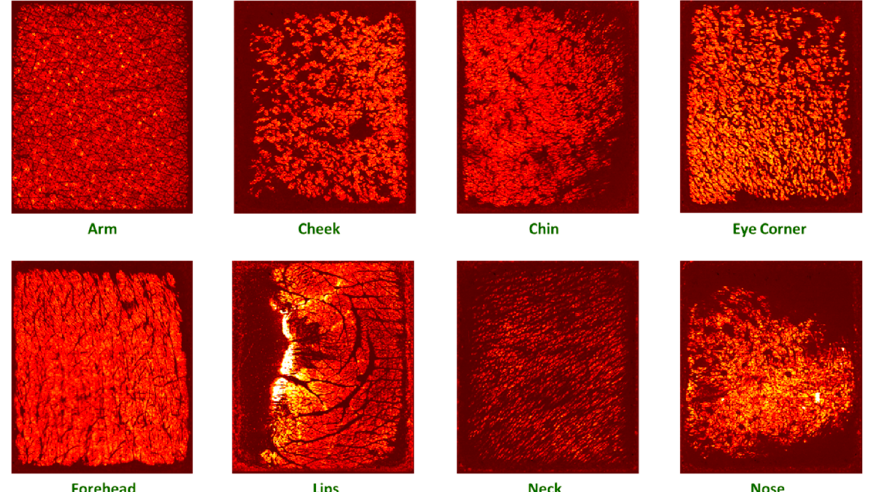
× 300 pixels) from different skin sites.